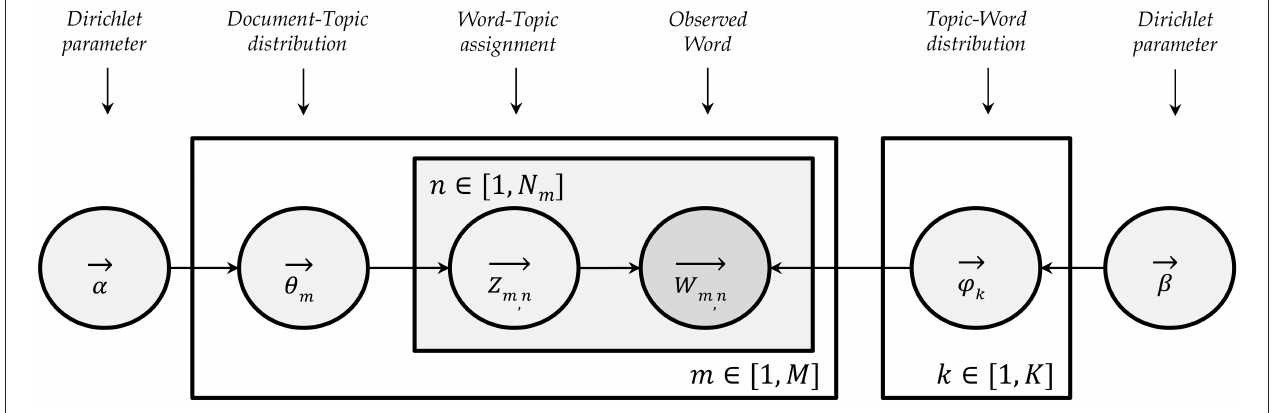
FIGURE 1 | Graphical model of latent Dirichlet allocation. Shaped after a graphic by Lee et al.